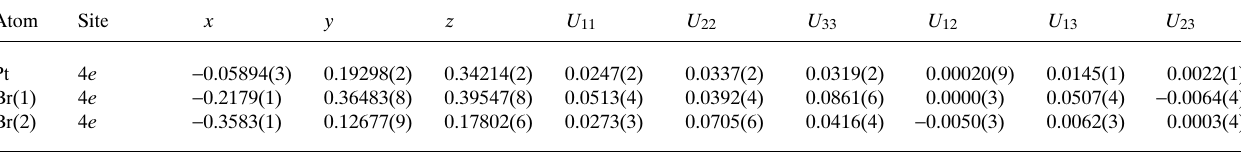
Table 3. Atomic coordinates and displacement parameters (in Å 2 )